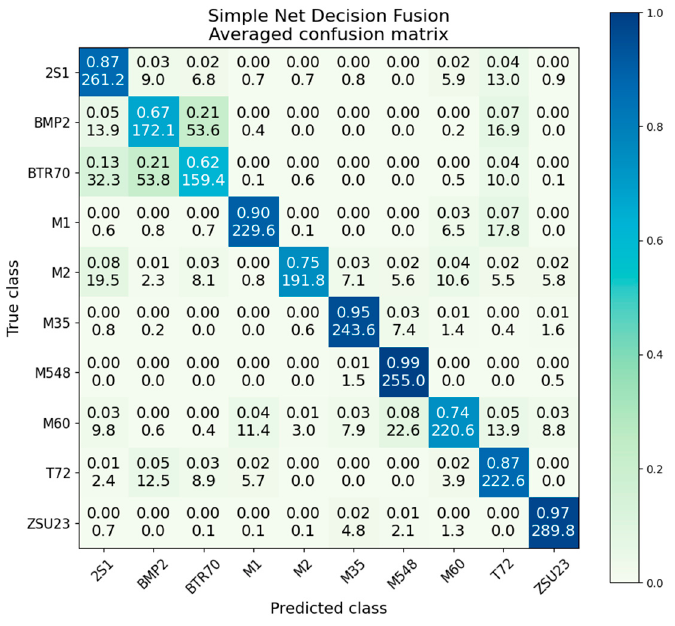
19 of 32 Figure 15. Accuracy distributions of decision fusion vs. SAR and EO. 5.6. Simple Net Decision Fusion Decision fusion with the results of the simple network in an accuracy of 83.4%, a gain of 11.6% over the better-performing SAR, and 15.2% over the worse − performing EO. The confusion matrix is given in Figure 16. While not as impressive of an accuracy as the Res-